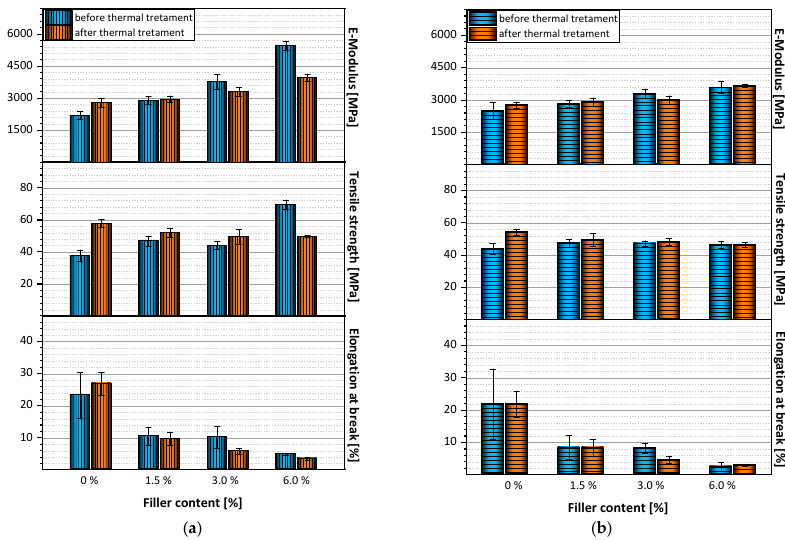
Figure 9. Mechanical properties of melt-extruded films before and after thermal treatment ( a ) in flow direction, ( b ) perpendicular to flow direction.